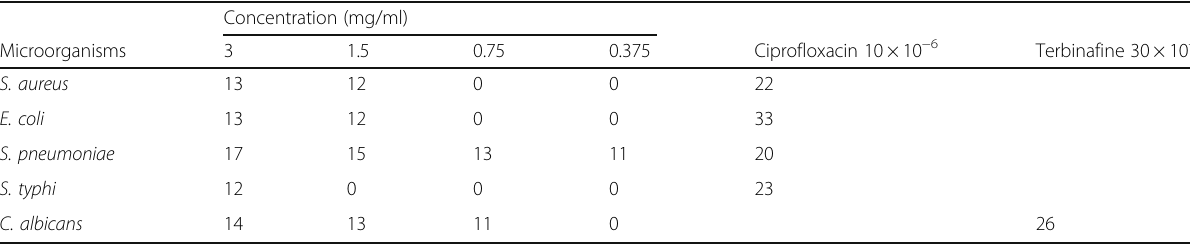
Table 2 Diameter of zone of inhibition (mm) of the isolate